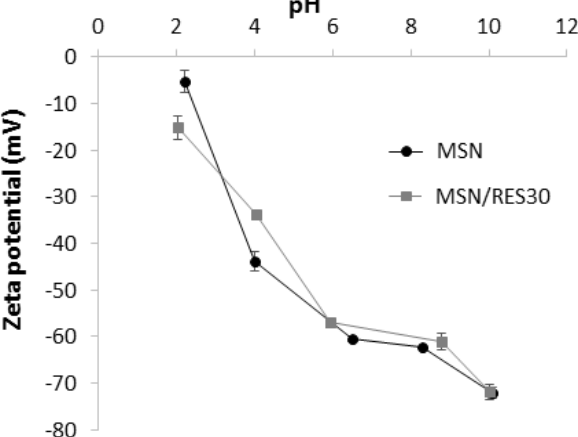
Figure 5. Zeta potential of pristine MSNs and RES-loaded MSNs at variable pH values.